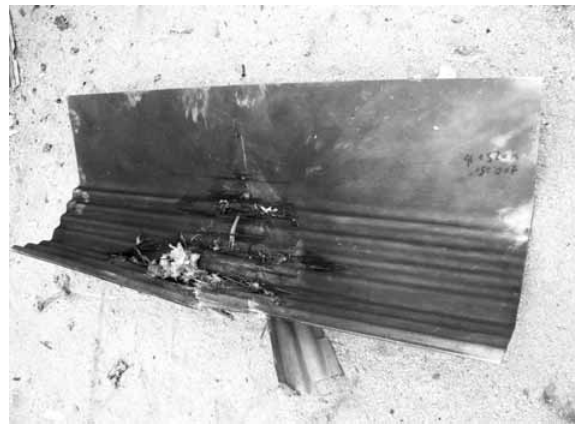
Fig. 20. Inside view of basic shield after test.